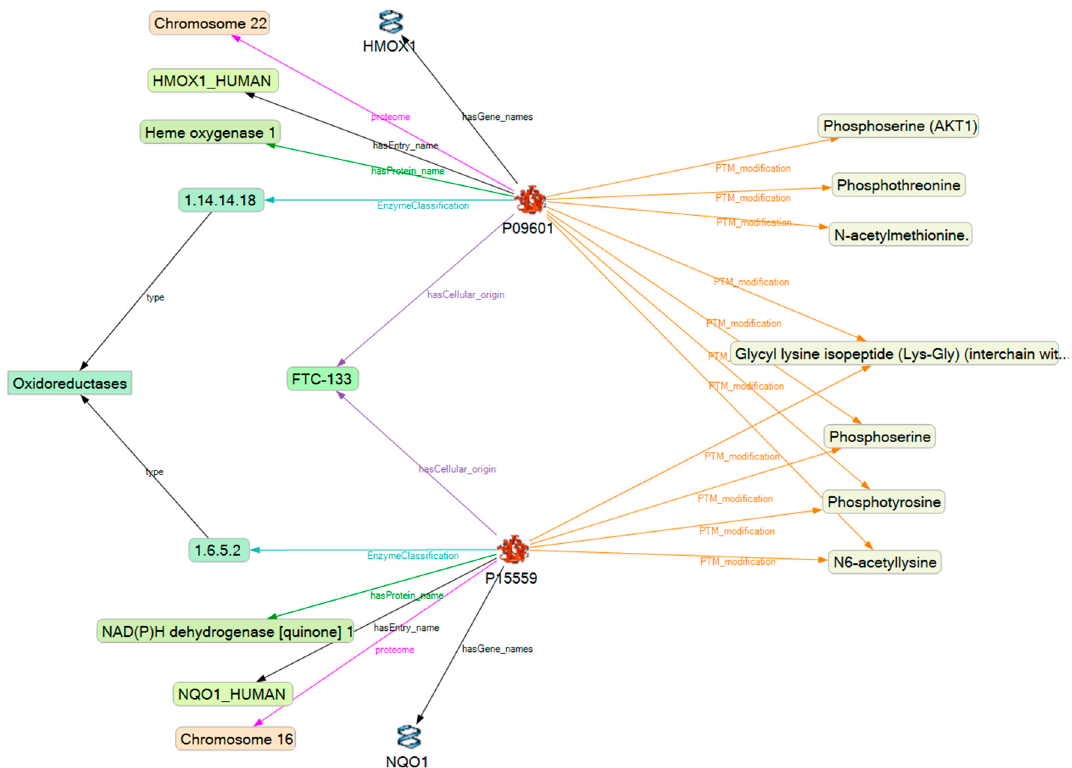
Figure 3. Uniprot derived starting network for heme oxygenase 1 and NAD(P)H dehydrogenase [quinone] 1. The network includes data about the proteins’ names and accession numbers, about enzyme classes, as well as about posttranslational modifications (PTMs) stored in UniProt [31]. Similar information was gathered for all the other proteins.